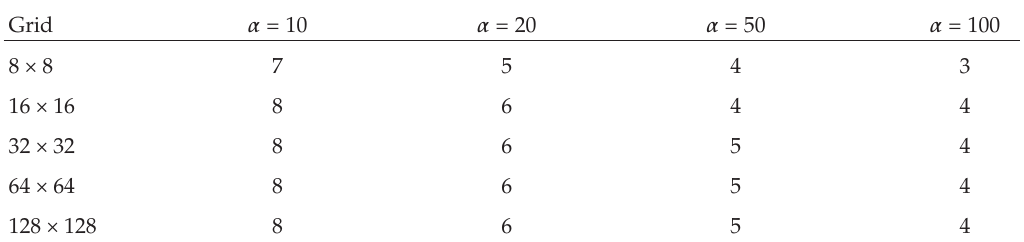
Table 1: Results for 2D unsteady Oseen problem di ff erent values of α (cid:5) exact solves (cid:6) and ν (cid:7) 0 . 1. Grid